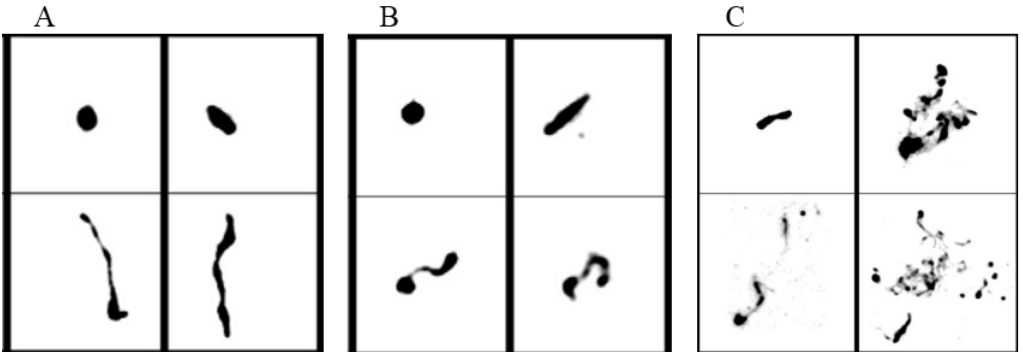
Figure 4. Visualized droplet deformation:( A ) flow structures which are larger than the droplet; ( B ) deformed droplets by flow structures that have the same or smaller scale than the droplet; and ( C ) droplets that are completely broken up; all images in the lower row were taken 1 ms after the droplets in the upper row. Reproduced with the permission from [87]; Lund Inst. of Technology, 2005.